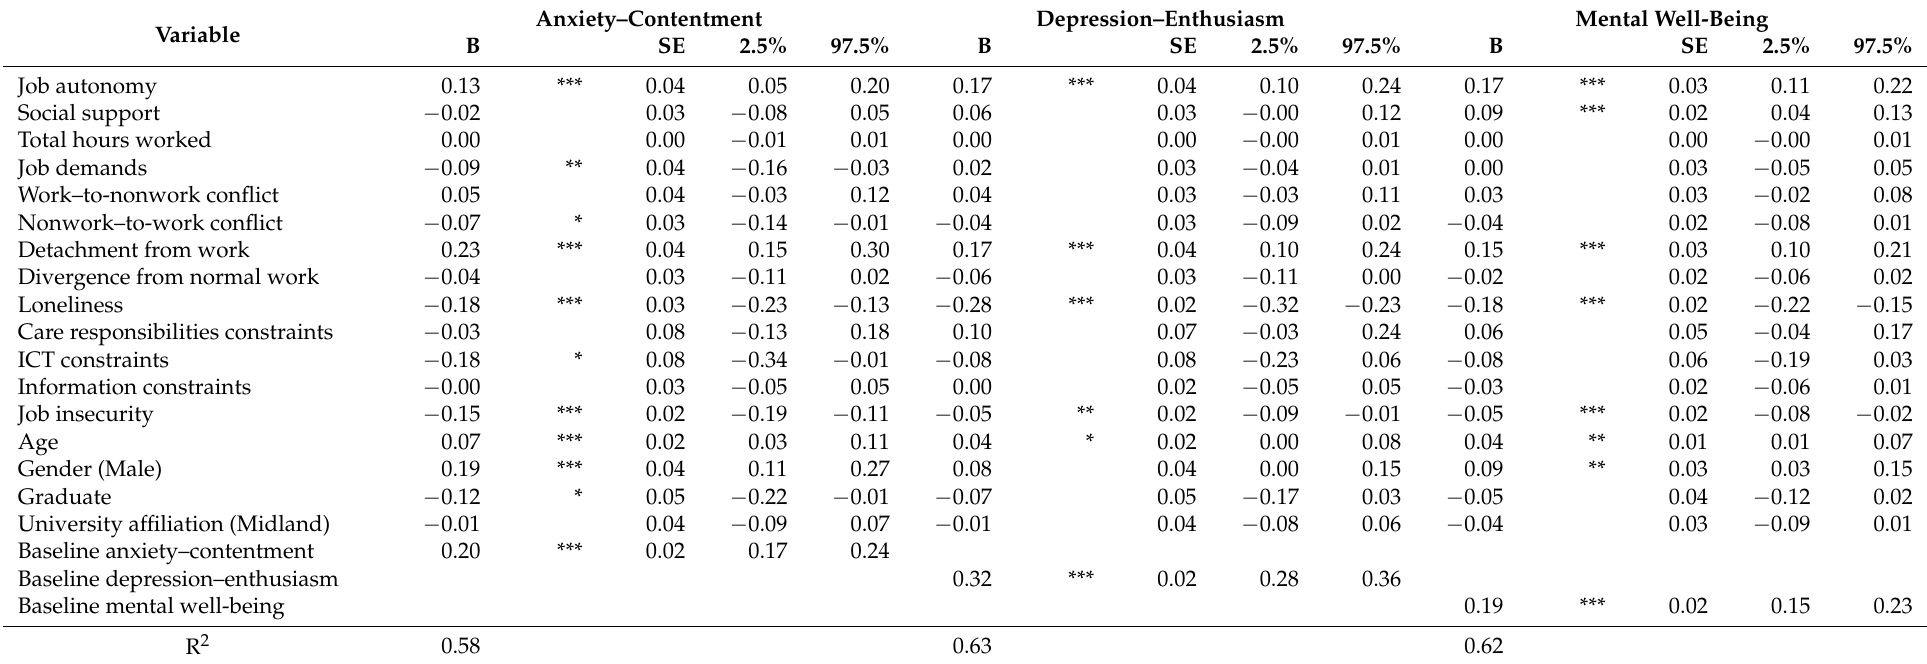
Table 6. Phase 1 between-person effects on